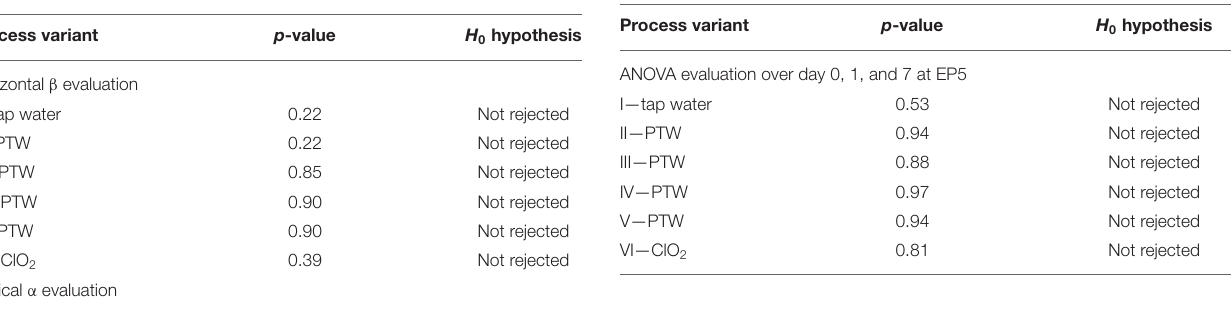
TABLE 5 | Statistical evaluation over all storage days (day 0, 1, and 7) at